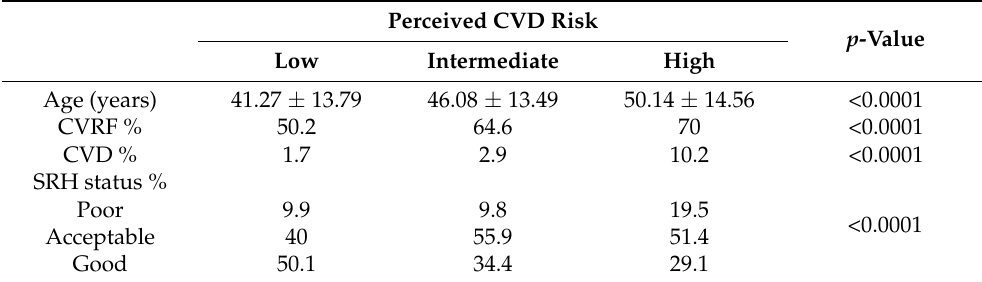
Table 4. Perceived CVD risk compared to demographics and clinical